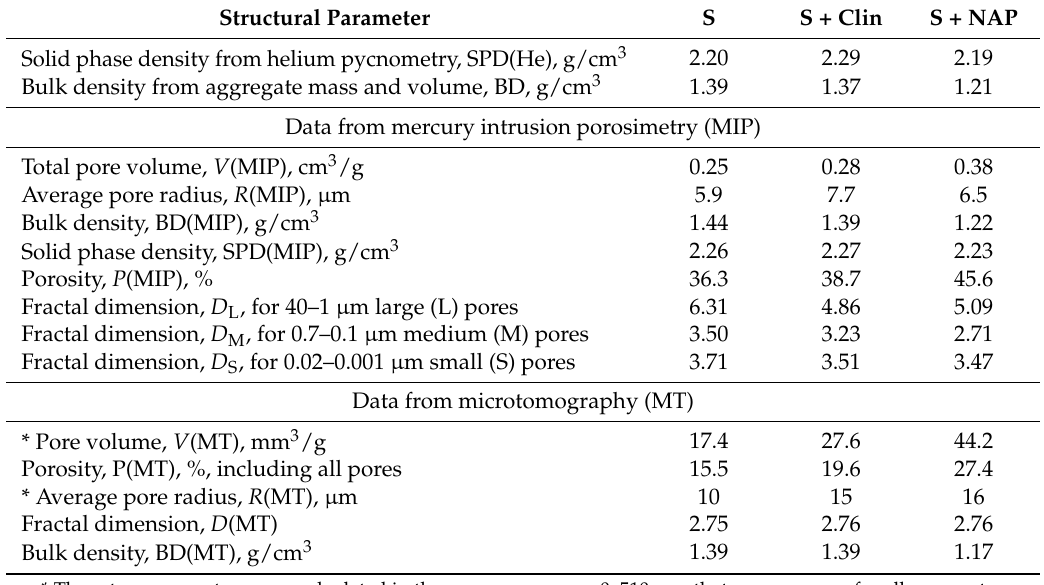
Table 1. The structural parameters of the control lightweight aggregates